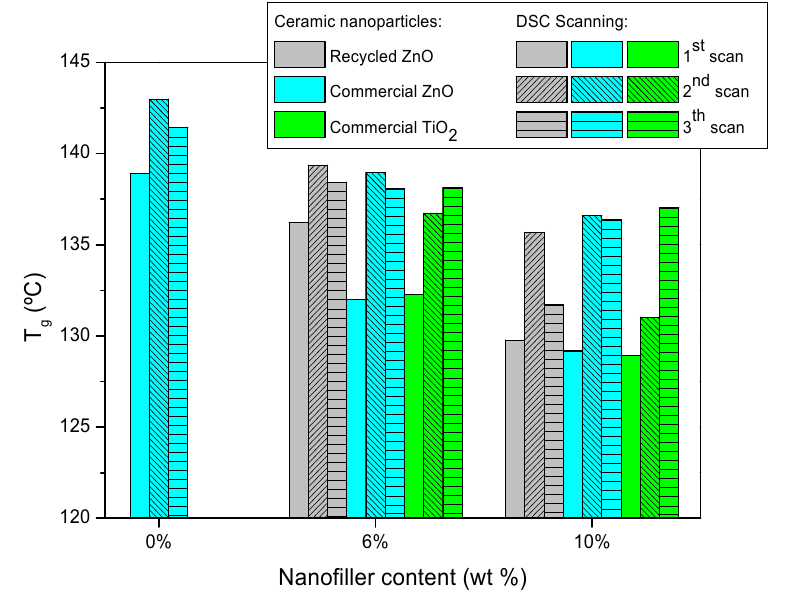
Figure 2. Glass transition temperature, measured by three consecutive DSC scans, for the studied epoxy composites reinforced with ceramic nanoparticles.